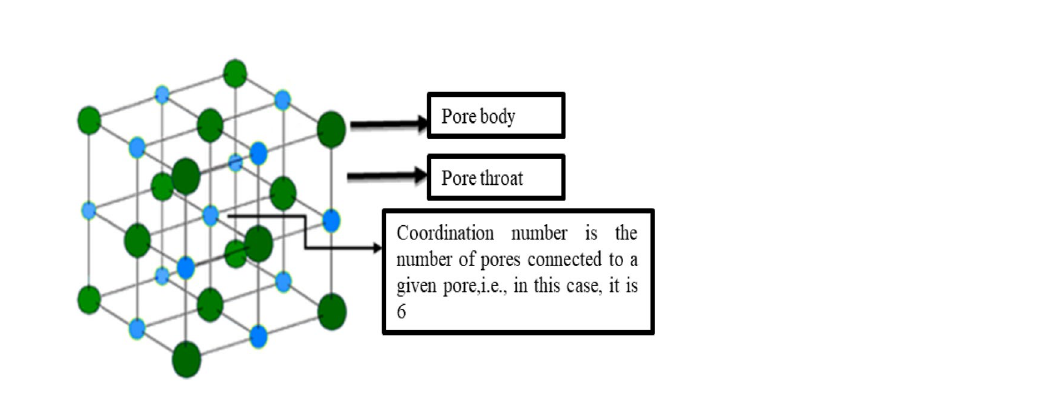
Figure 7. Correlation between clay content and porosity loss.